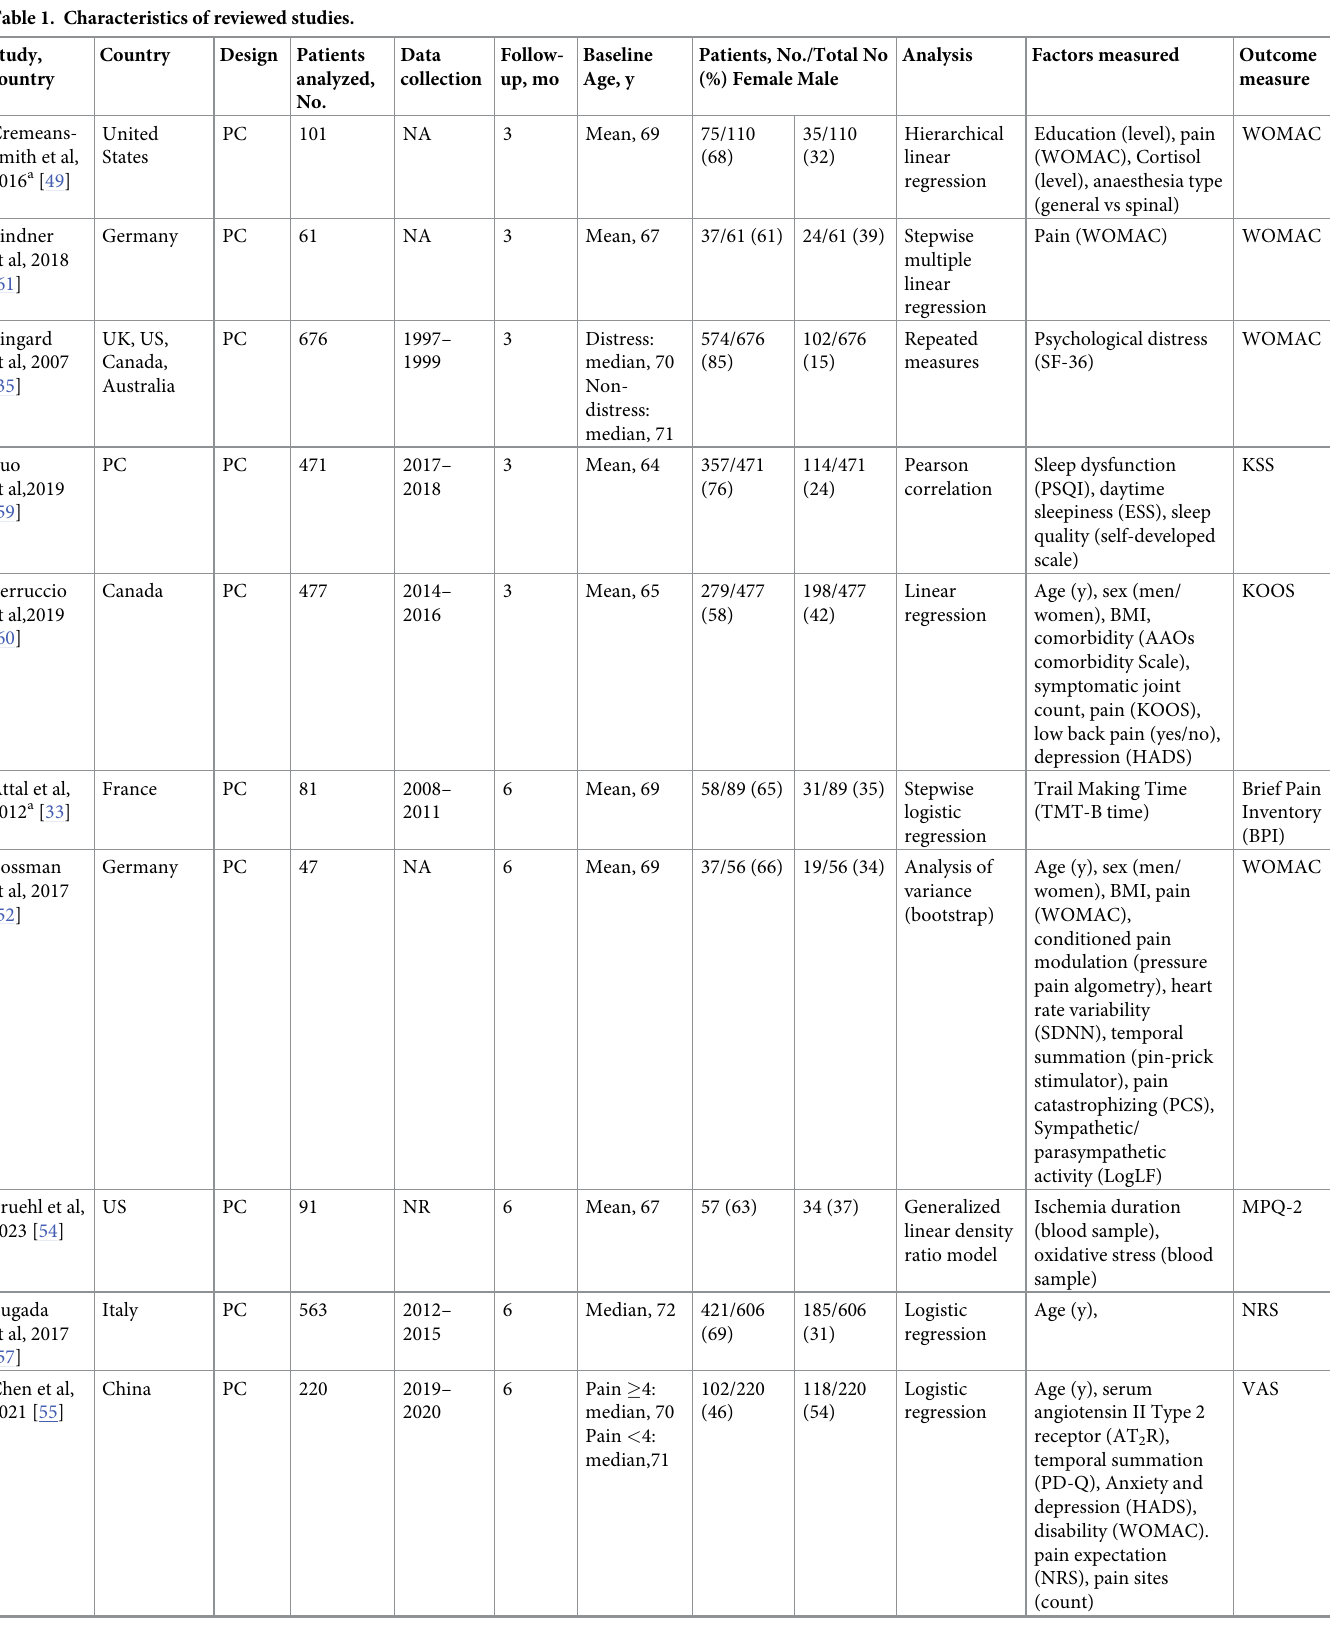
Table 1. Characteristics of reviewed